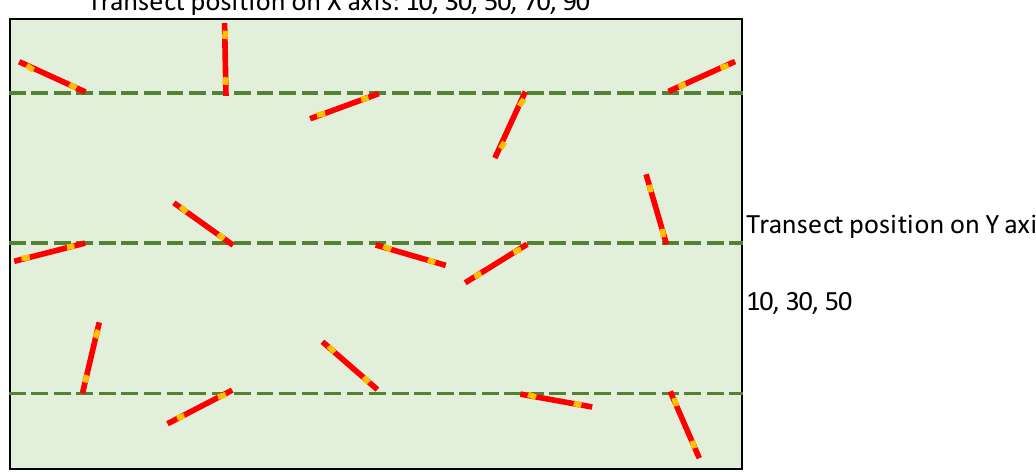
Figure 7. Example of transect layout for a forest inventory area of 0.5 ha: 50 × 100 m. The transects, 10 m long (in red), are represented in red ( n = 15) and their starting points are evenly located along the X and Y axes. Woody debris pieces intersecting the transects are measured:very fine woody debris (VFWD) on two sub-sections of 0.5 m (yellow small lines within the red transects), large fine woody debris (LFWD) and coarse woody debris (CWD) along the whole transect. For CWD, extra inventory length can be added (dashed lines in green, corresponding to 300 additional meters).